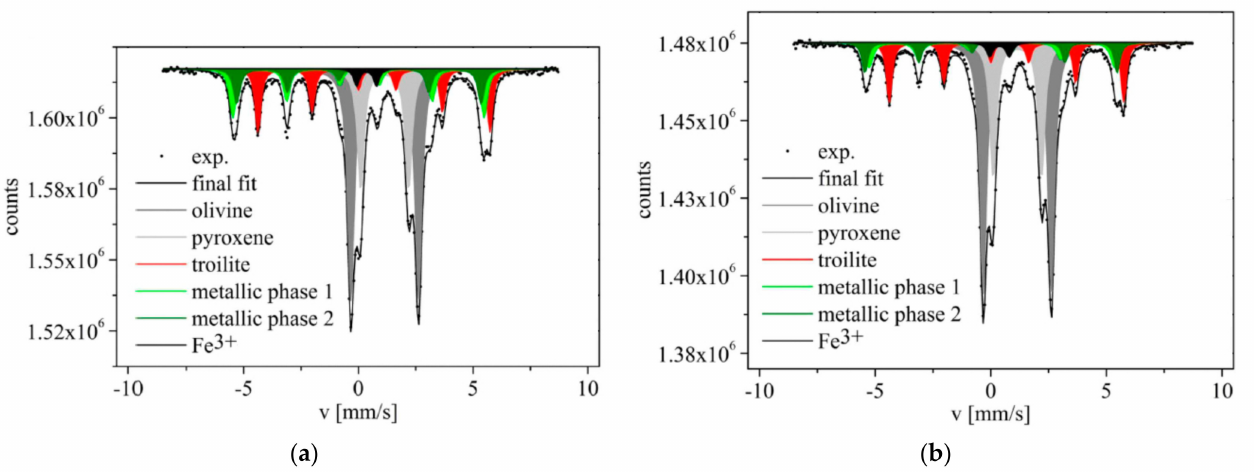
Figure 20. Room temperature Mössbauer spectra of equilibrated ordinary chondrites Buzzard Coulee H4 ( a ) and Bassik- ounou H5 ( b ). Indicated components are the results of the fits. Adapted from Reference [57].